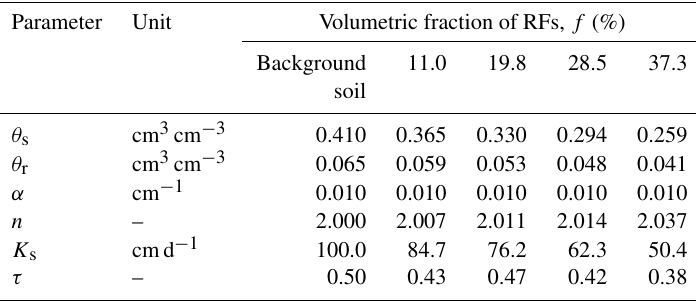
Figure 4. The time series of the 3D-simulated (circles) and 1D-fitted (solid lines) pressure heads at the observation points at three depths of the stony soil columns with the f values of (a) 11.0%, (b) 19.8%, (c) 28.5%, and (d) 37.3%. The observation depths are indicated using different colors: orange (upper, 2.5cm), green (middle, 5.0cm), and blue (lower, 7.5cm from the top). Table 2. The van Genuchten model parameters of the SHPs of the background soil and of the inversely determined effective SHPs of the virtual stony soils with different values of f